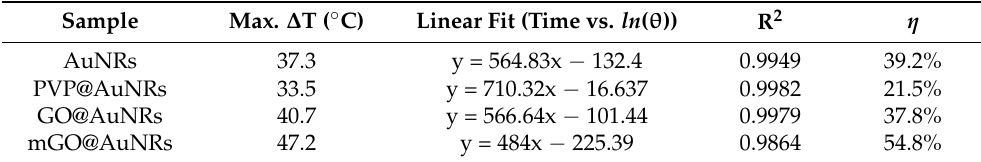
Table 1. Tabulated summary of temperature change and the photothermal conversion